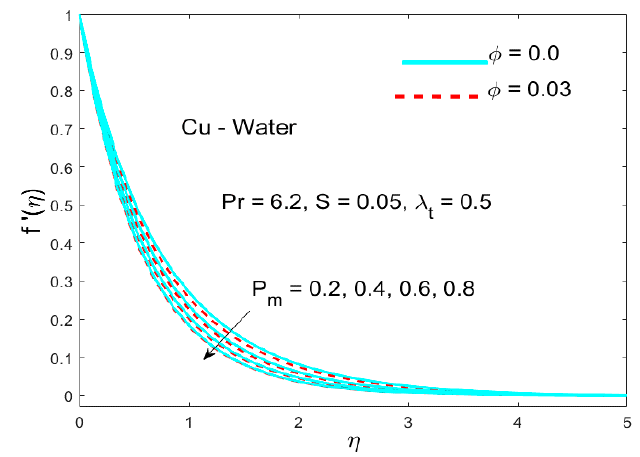
Figure 4. Influence of P m on the axial velocity.